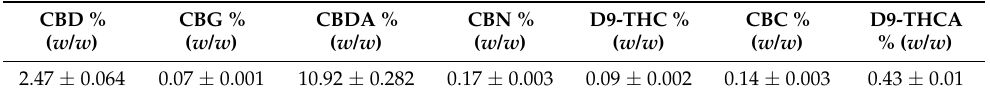
Table 10. Conventional extraction of cannabinoids from cannabis plant